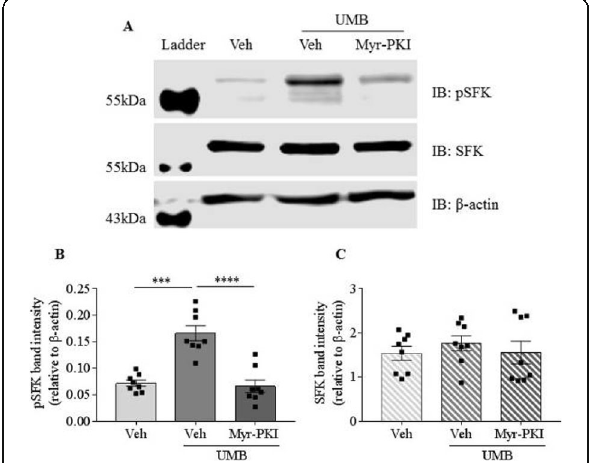
Fig. 1 (abstract P0256). See text for description